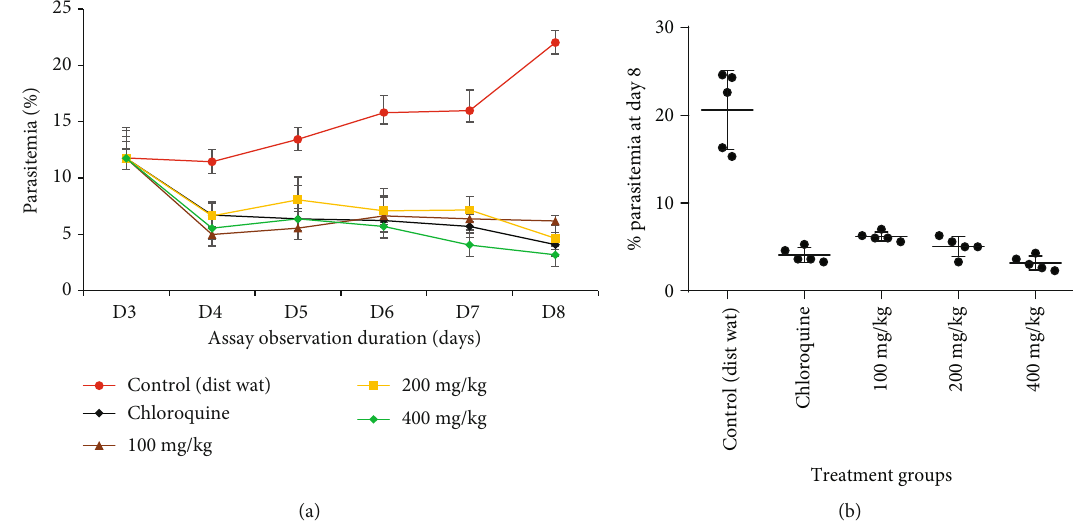
Figure 2: Curative e ff ect of Tm sb w as compared to chloroquine (CQ) and the negative control (NC). (a) E ff ects of Tm sb w on the parasitemia of infected mice during the whole treatment time. (b) E ff ect of Tm sb w on the parasitemia of infected mice on day 8.